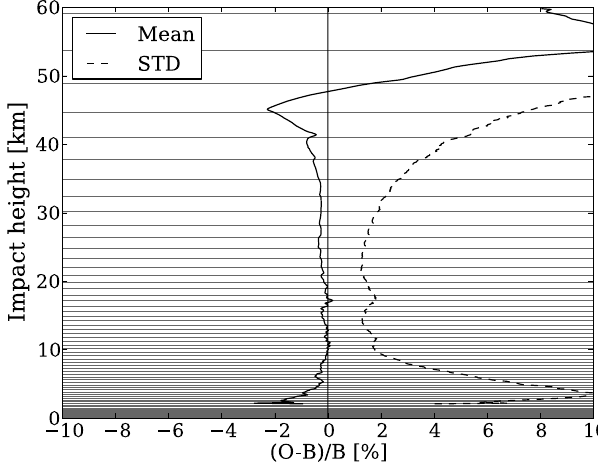
Figure 5. Bending angle innovation statistics using an integrable approximation to the dry hydrostatic refractivity at all heights, i.e. Eq. (19). See Sect. A3 for full